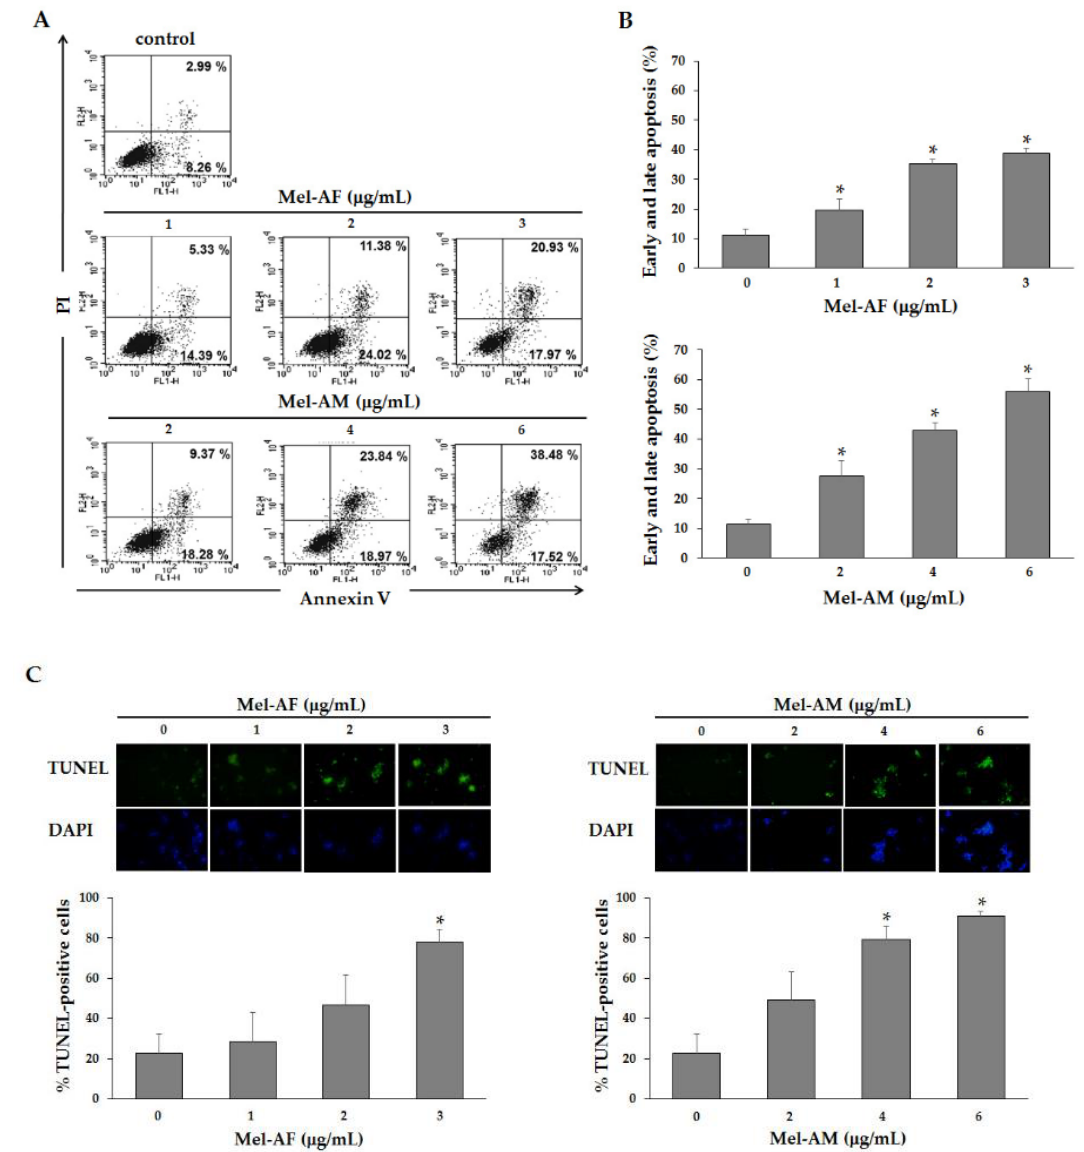
Figure 4. E ff ect of Mel-AF on apoptosis induction in A375 cells. Cells were treated with the indicated concentrations of Mel-AF (or Mel-AM) for 2 h. ( A ) Cells were then stained with FITC-Annexin V and PI to analyze early apoptotic (Annexin V + PI − ) and late apoptotic / death (Annexin V + PI + ) by flow cytometry. ( B ) Histogram shows the percentages of apoptotic cells for each treated sample at 2 h. ( C ) DNA fragmentation in treated cells were studied by TUNEL assay and analyzed by Flow cytometer. Data are presented as the mean ± SEM values of three independent experiments performed in triplicate. * p < 0.05 was determined by one-way analysis of variance.